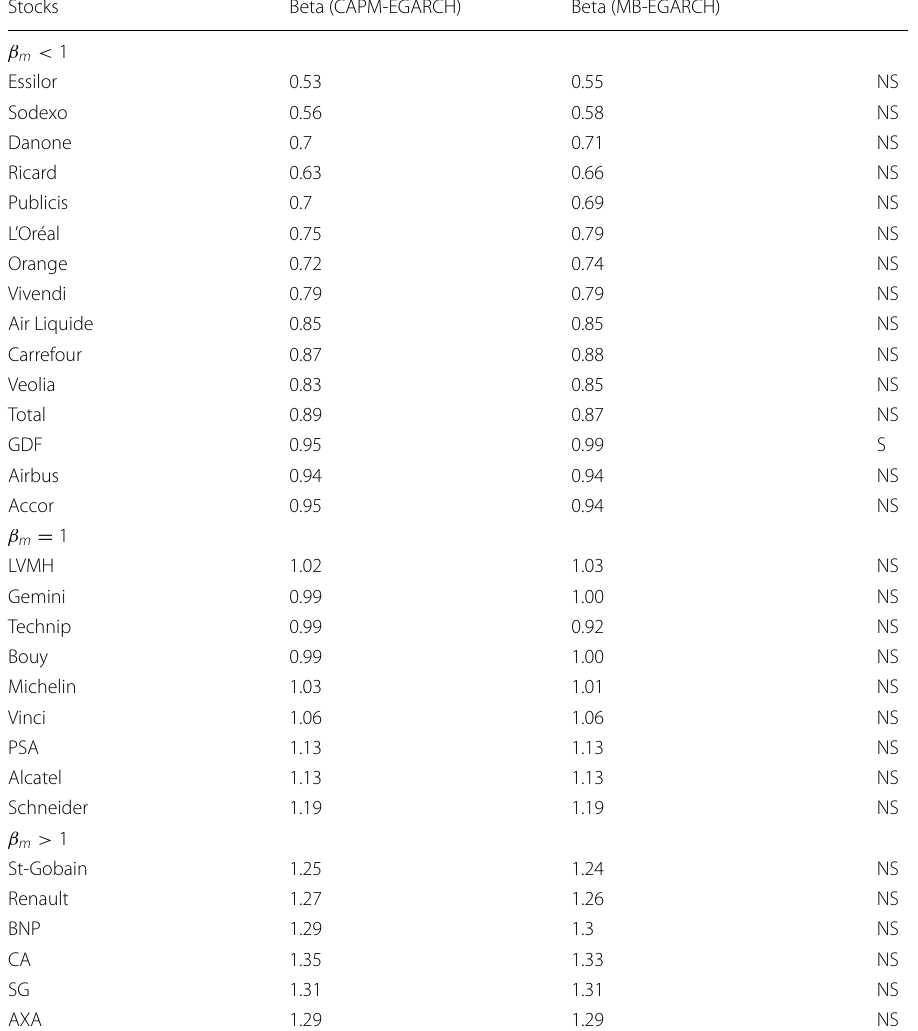
Table 10 Comparison of β m between CAPM-EGARCH and